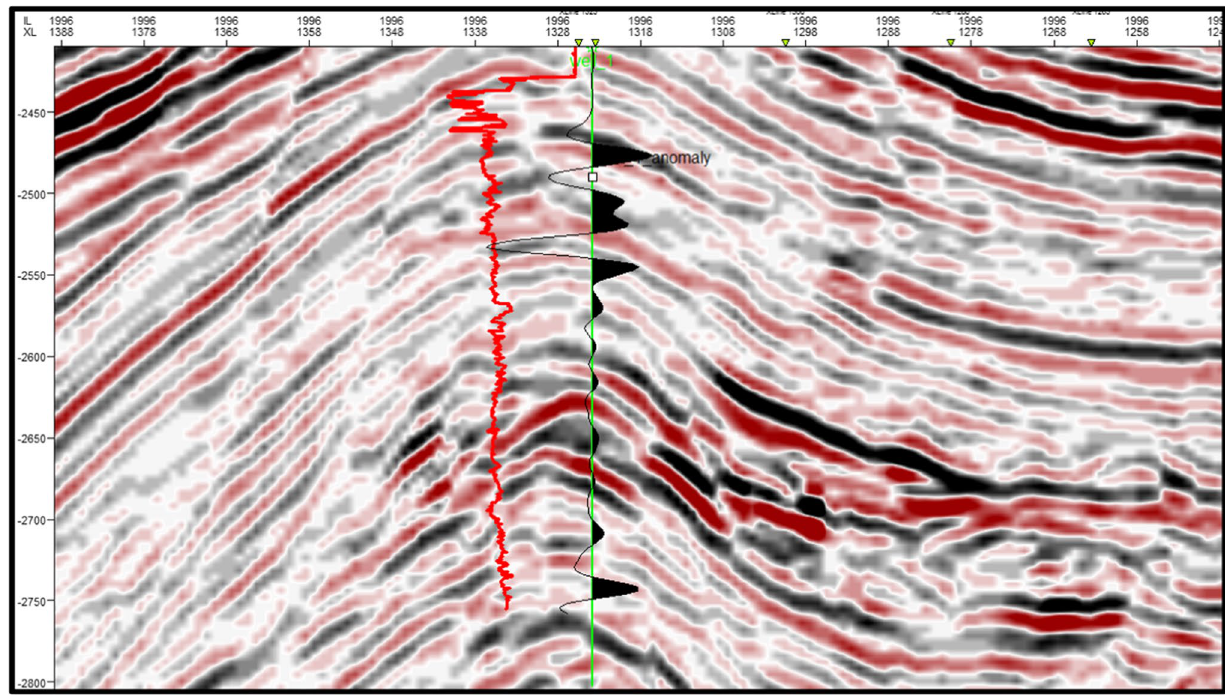
Fig. 14 Well_1 synthetic seismogram; the bright spot anomaly is completely disappeared in the raw synthetic seismogram, which excluded the over-pressured zone in the target zone, supporting the artificial bright spot